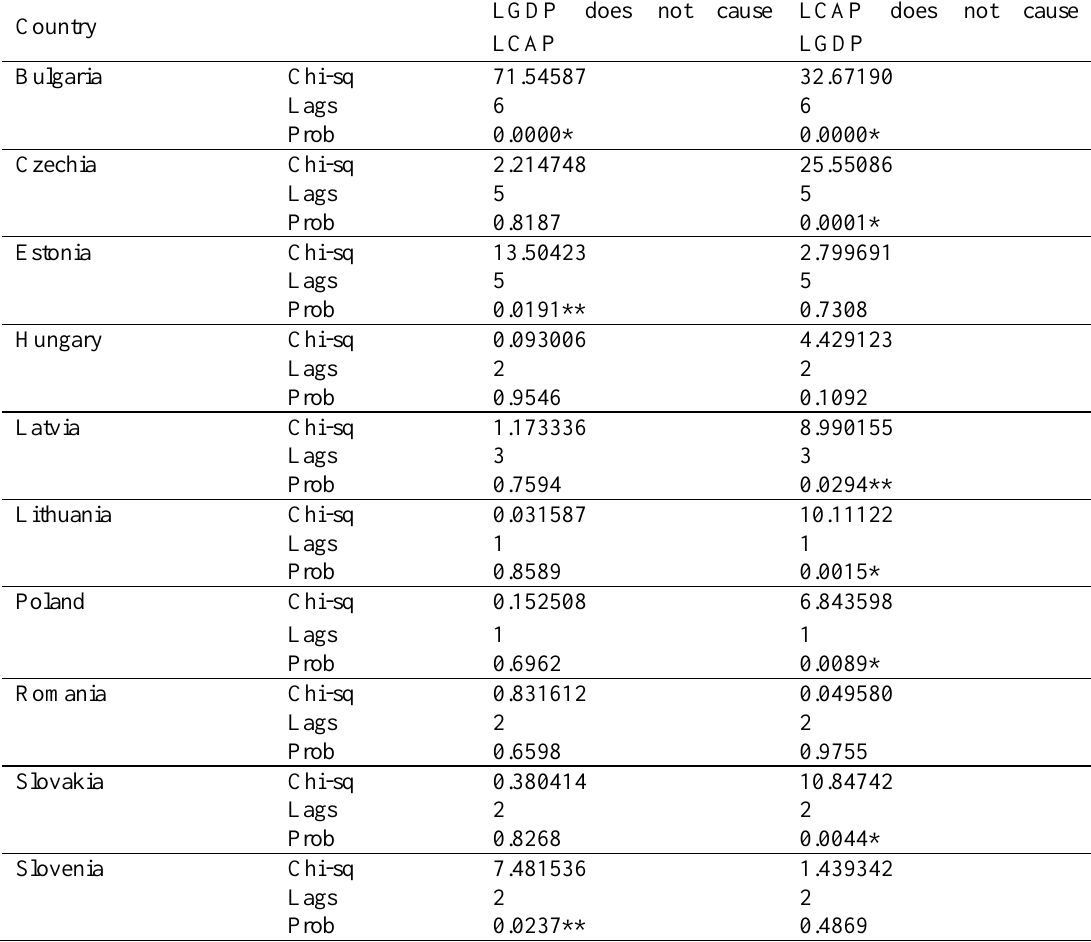
Table 4. Granger Causality